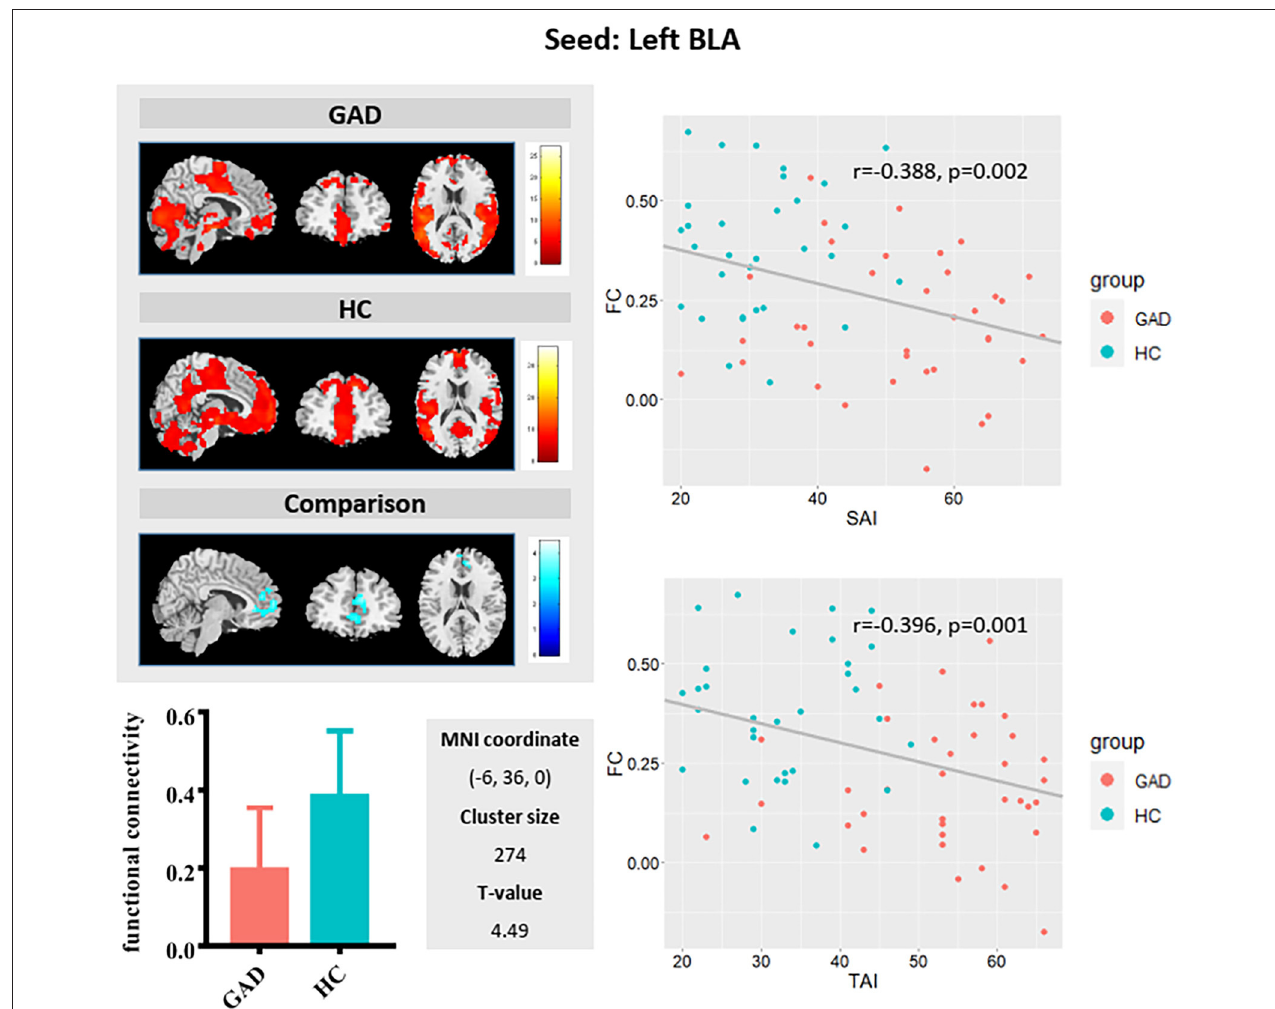
FIGURE 1 | Left basolateral amygdala (BLA) functional connectivity (upper left panel) in generalized anxiety disorder (GAD) patients (first row) and in healthy controls (HCs; second row), and group differences shown in the third row. Compared with HCs, GAD patients showed weaker functional connectivity between the left BLA and anterior cingulate/medial prefrontal cortices (see bar graph in lower left panel). As shown in the scatterplot (right panel), a weaker FC between the left BLA and anterior cingulate/medial prefrontal cortices is associated with a higher-state anxiety and trait anxiety score in the sample as a